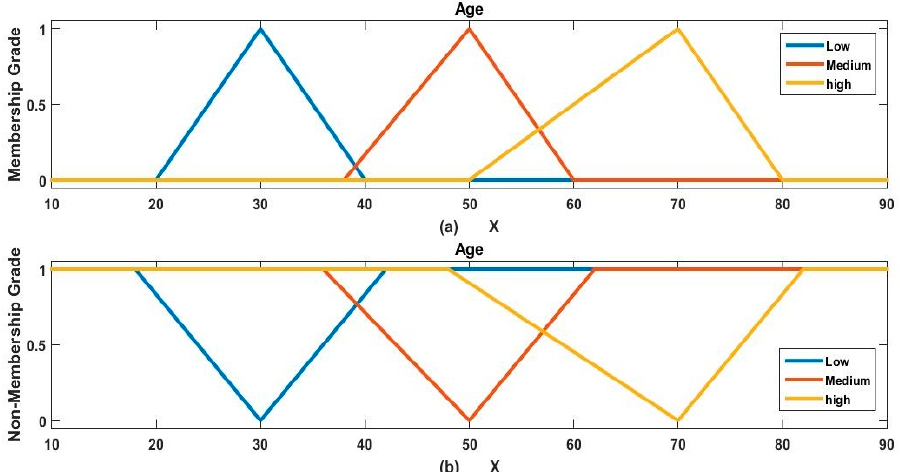
Figure 4. Three linguistic categories of pulse rate with their trapezoidal membership ( a ) and non-membership grades ( b ).